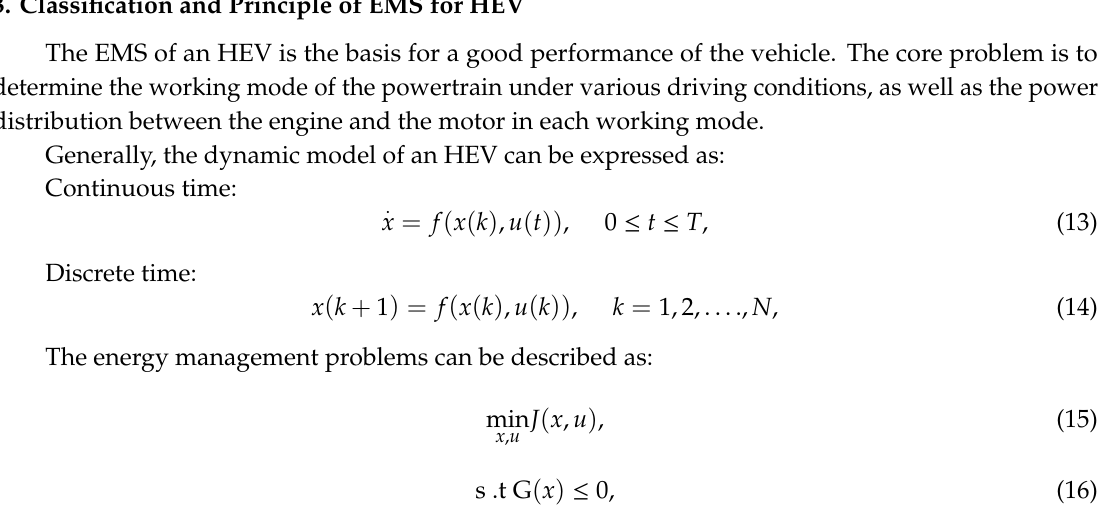
Figure 9. Working characteristics of plug-in HEVs. SoC: state of